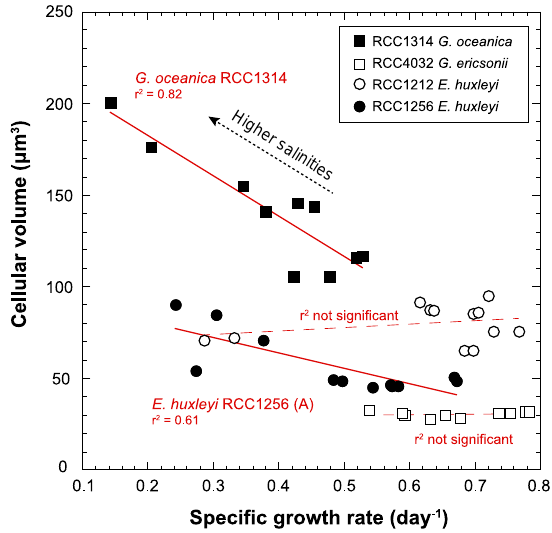
Figure 4. Covariations between growth rate and cell size of coc- colithophores grown under various salinities. The conversion of the cell diameters into volumes have been achieved considering that the cells have are spherical. RCC1314 G. oceanica and RCC1256 E. huxleyi A show correlated changes in these two ecological-relevant parameters, however with distinct influence of